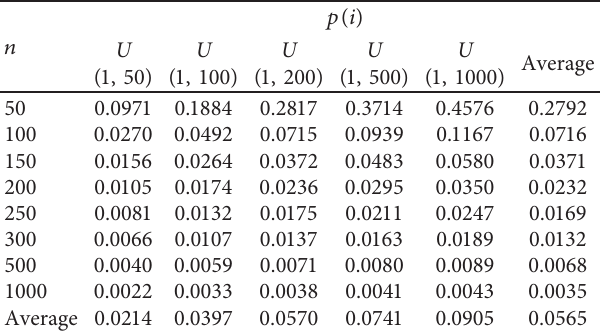
Table 1: Computational results of the LPT approach with five different processing time distribution